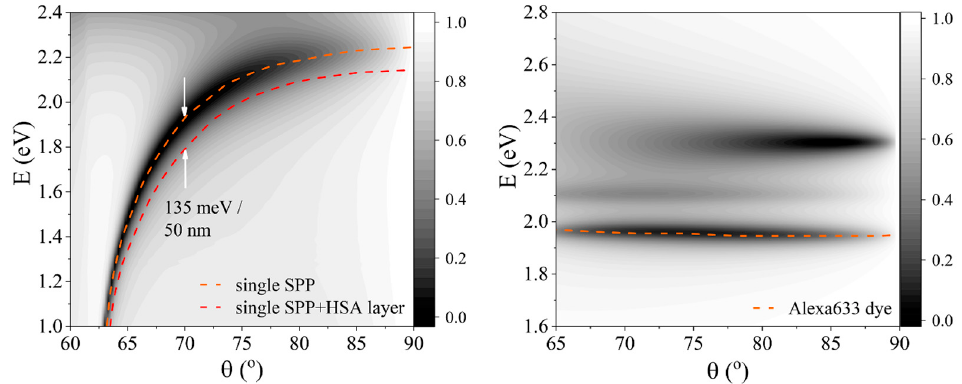
Figure 2. The p ‐ polarization reflected intensity maps of the SPP ( left ) and exciton ( right ) dispersion relations. The orange lines mark the SPP excitation minima and the Alexa Fluor TM 633 dye absorption peak, while red line represents the minima of SPP when 11 nm HSA protein layer is formed on gold’s surface, where white arrows mark the 50 nm spectral shift (at 70 ° AOI) due to the presence of 11 nm HSA layer.